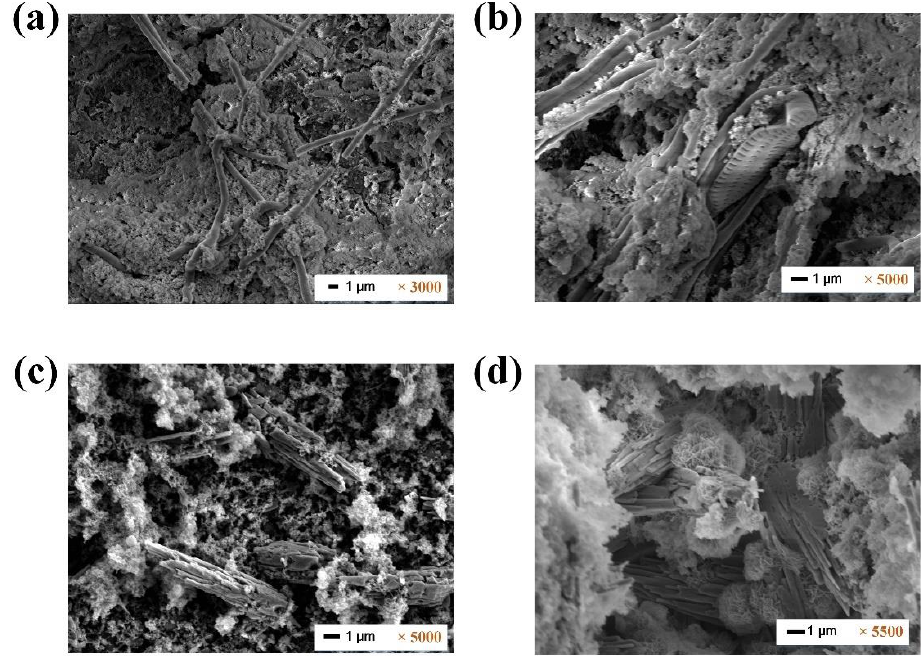
Figure 8. FESEM images of the RO fouled membrane surfaces ( a , b ) with CAF pretreatment and ( c , d ) without CAF pre-treatment from the 2nd evaluation (i.e., with daily CAF backwash).